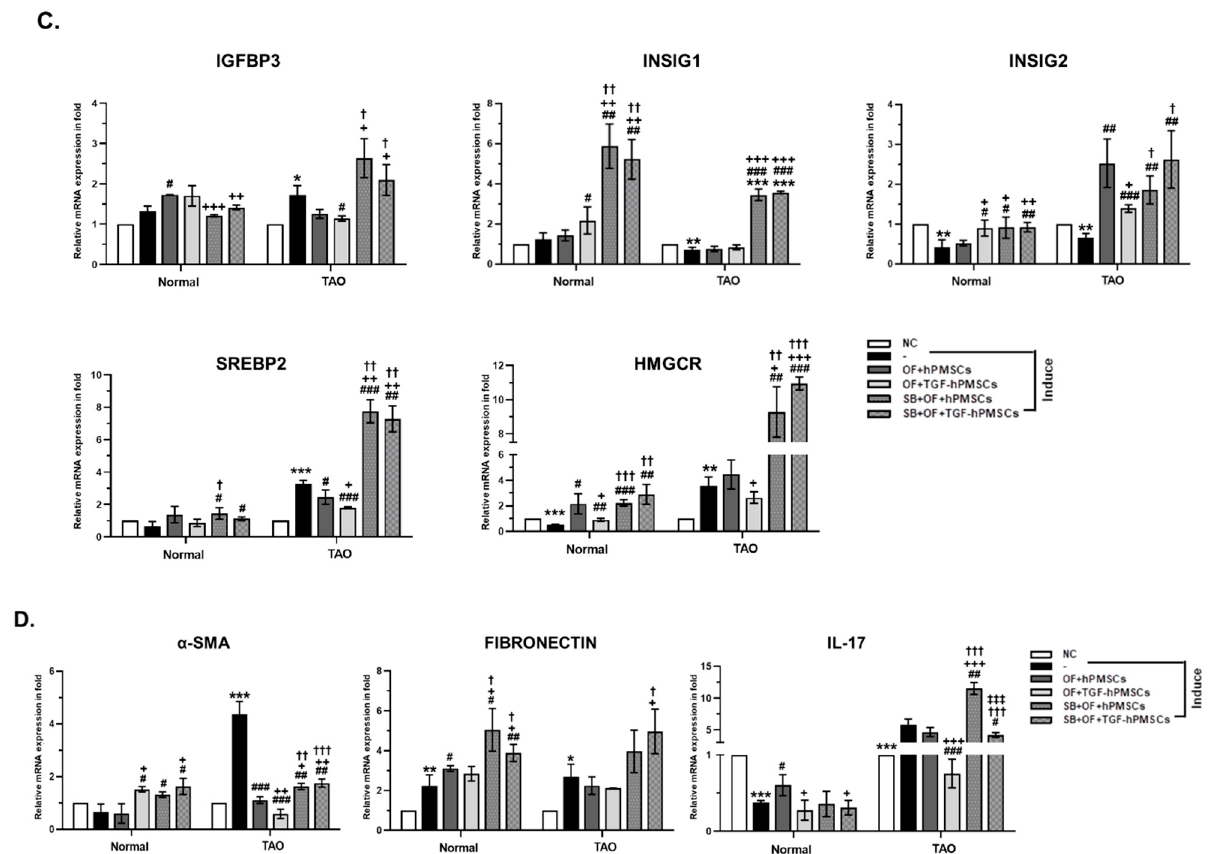
Figure 2. TGF β -hPMSCs inhibit adipogenesis, lipogenesis, and fibrosis in TAO-derived OFs. ( A ) The mRNA expressions of adipogenesis marker genes (e.g., PPAR γ , C/EBP α , LEPTIN , and aP2 ) were analyzed by RT-qPCR. ( B ) Quantification of ORO staining in differentiated OFs. The graph shows relative quantification at 470 nm absorbance. Data were presented as a fold change (mean ± SEM). ( C ) The mRNA expressions of lipogenesis genes (e.g., IGFBP3 , INSIG1 , INSIG2 , SREBP2 , and HMGCR ). ( D ) Fibrosis and inflammation genes (e.g., α -SMA , FIBRONECTIN , and IL17 ) were analyzed by RT-qPCR. Significantly different values between the groups are indicated with marks (* p < 0.05, ** p < 0.01, *** p < 0.001 Negative control vs. adipogenesis-induced OFs (-); # p < 0.05, ## p < 0.01, ### p < 0.001 vs. adipogenesis-induced OFs (-); + p < 0.05, ++ p < 0.01, +++ p < 0.001 vs. OF + hPMSCs; † p < 0.05, †† p < 0.01, ††† p < 0.001 vs. OF + TGF β -hPMSCs; ‡ p < 0.05, ‡‡‡ p < 0.001 vs. SB + OF + hPMSCs). The time-dependent manner of gene expressions was analyzed as follows: day 2 ( PPAR γ ); day 4 ( C/EBP α , LEPTIN , SREBP2 , HMGCR , and IL-17 ); day 10 ( aP2 , IGFBP3 , INSIG1 , INSIG2 , α -SMA , and FIBRONECTIN ).